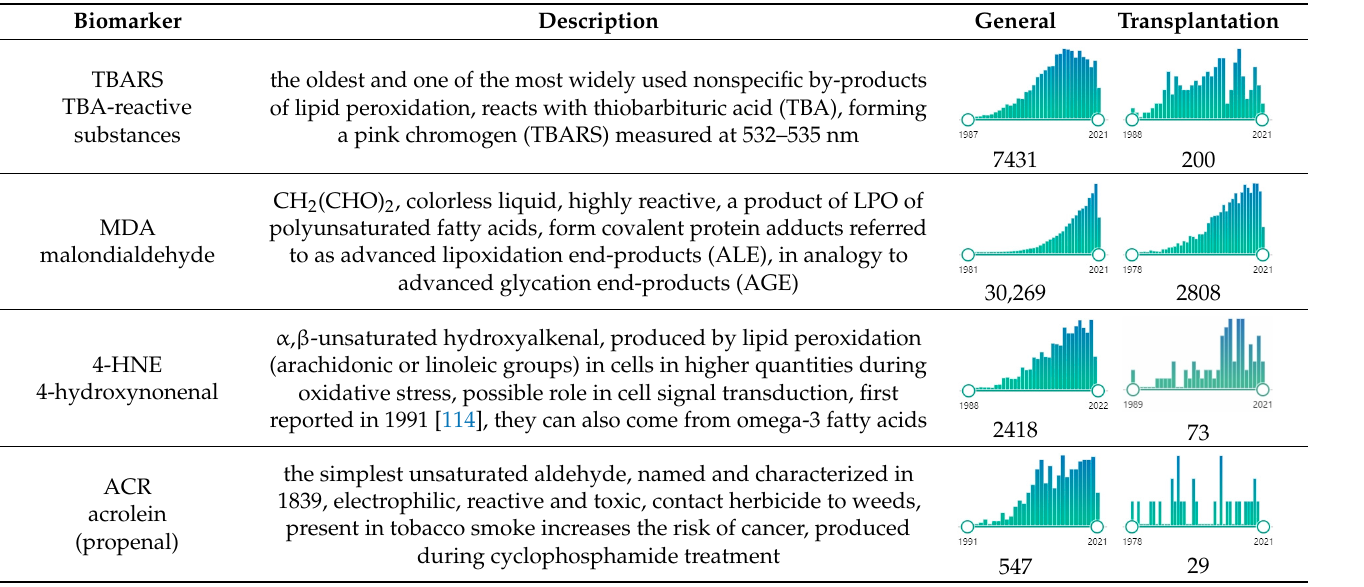
Table 3. Biomarkers of lipid peroxidation—description and research interest.